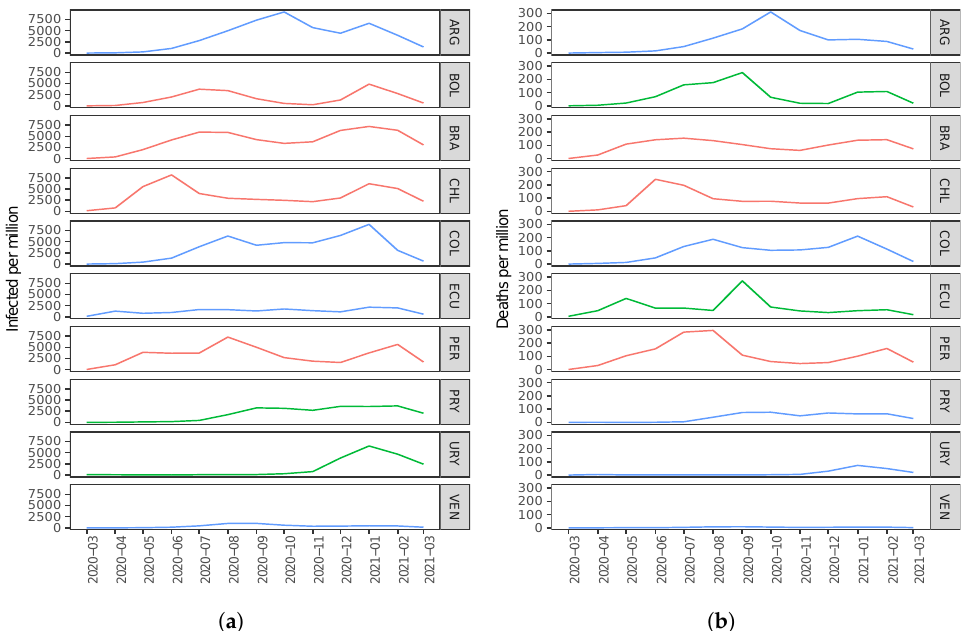
Figure 3. Plots of the number of COVID-19 ( a ) infected cases and ( b ) deaths for the indicated country and